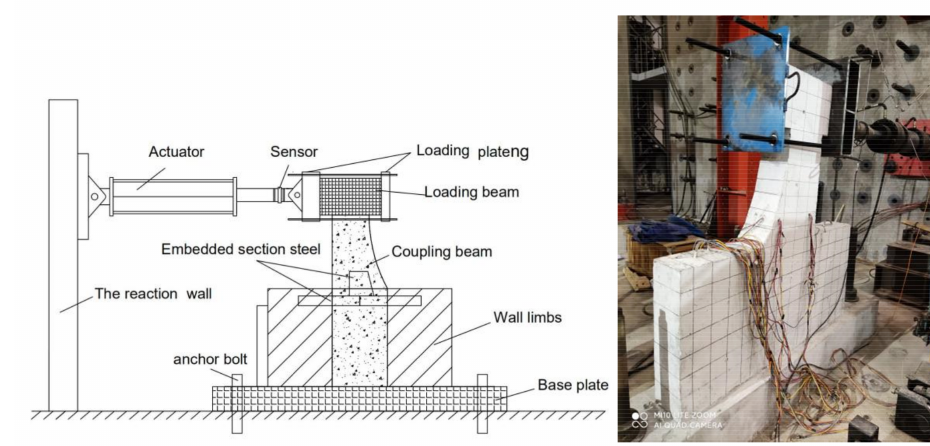
Figure 10. Loading layout.